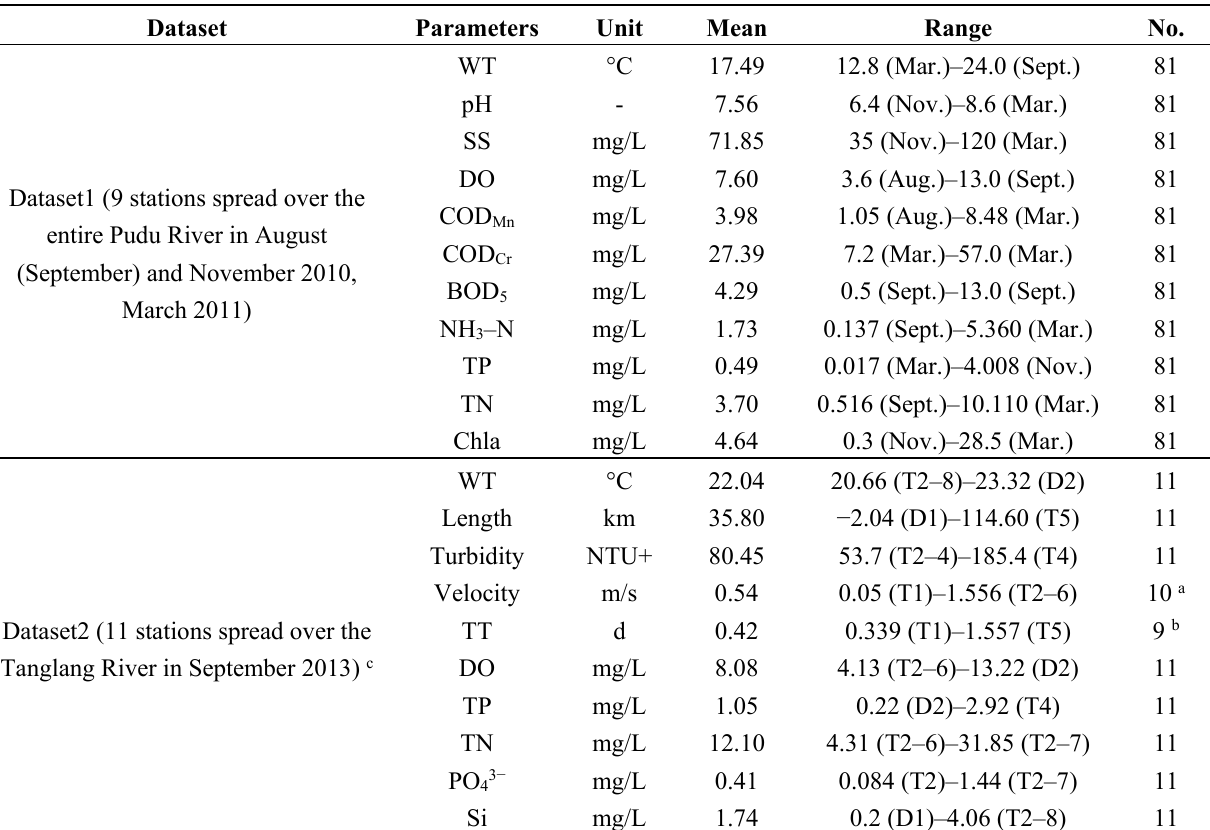
Table 1. Mean and range of environmental parameters in Dataset1 and